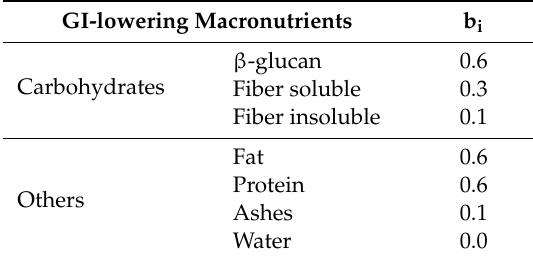
Table 3. GI-lowering power (b i ) of common macronutrient as defined by empirical data fitting for starch-based